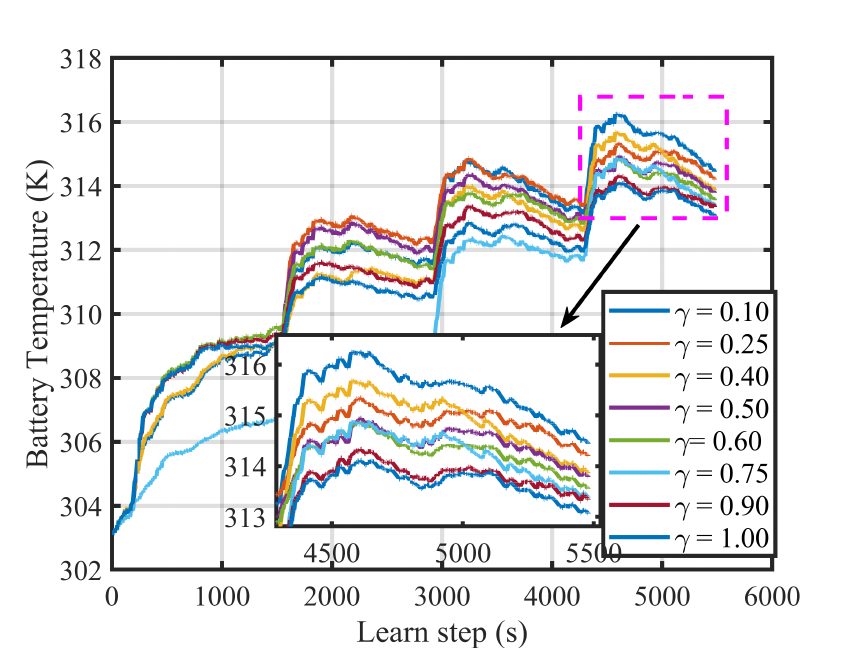
Figure 9. Battery temperature rise curves of different γ in 4 × UDDS. Table 4. Simulation results comparison between different γ